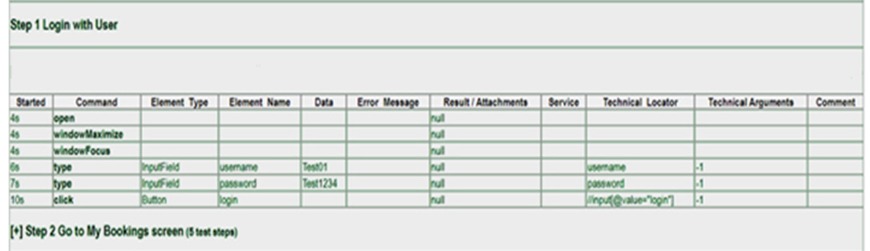
Fig. 8. Login method